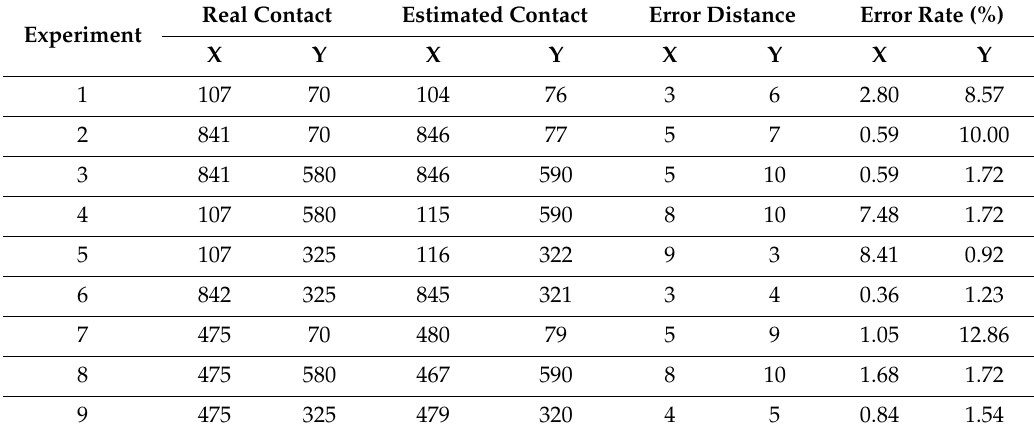
Table 2. Contact coordinate position comparison and error analysis (unit: pixel).